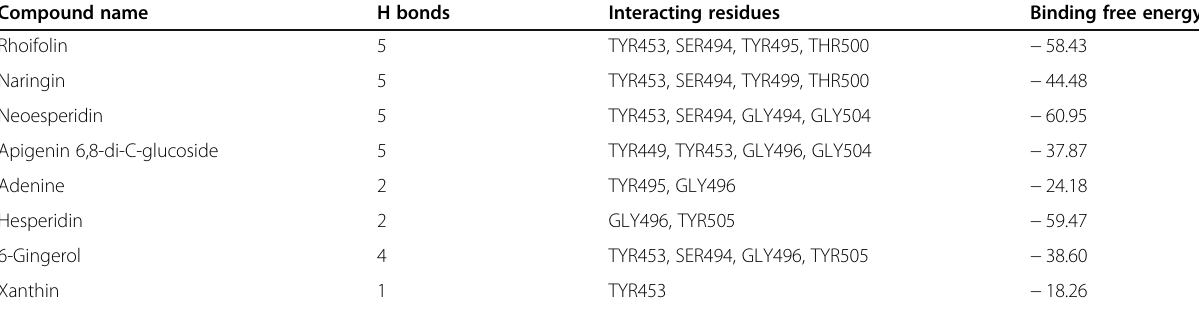
Table 2 Spike protein binding free energies of top-scoring